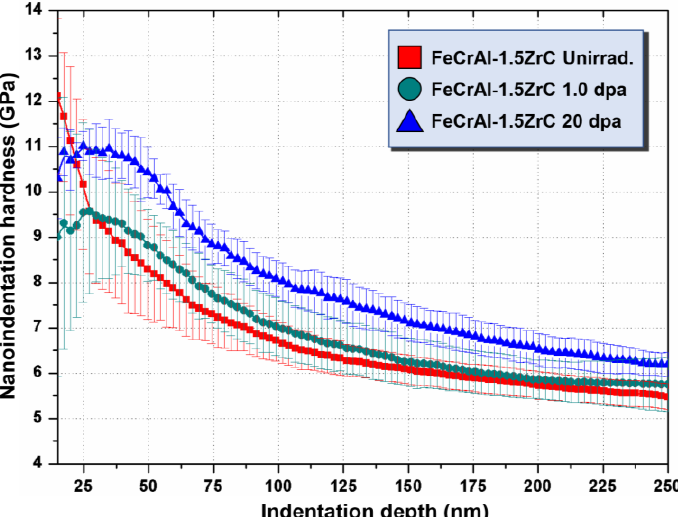
Figure 2. Curves of H and h for average nanoindentation hardness of specimens at different irradiation doses. The red line, green line and blue line represent the variation of hardness with indentation depth of unirradiated, 1.0 dpa and 20 dpa specimens, respectively.